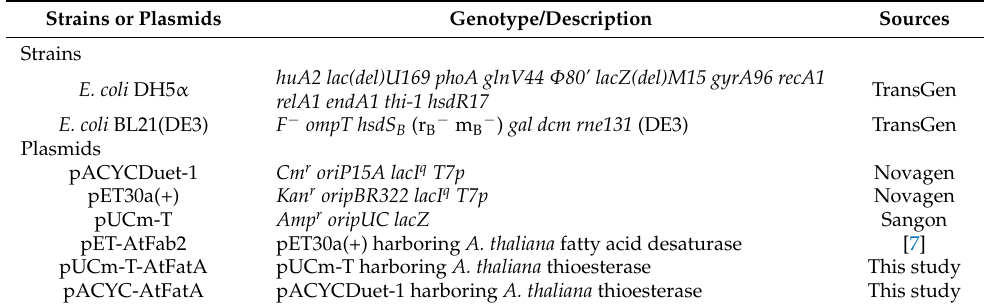
Table 1. Strains and plasmids used in this